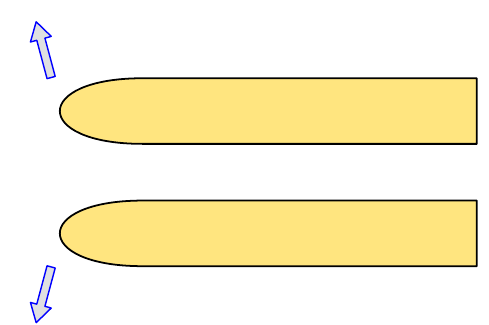
Fig. 4. Pressure distribution of the ships following parallel directions and turning tendencies for